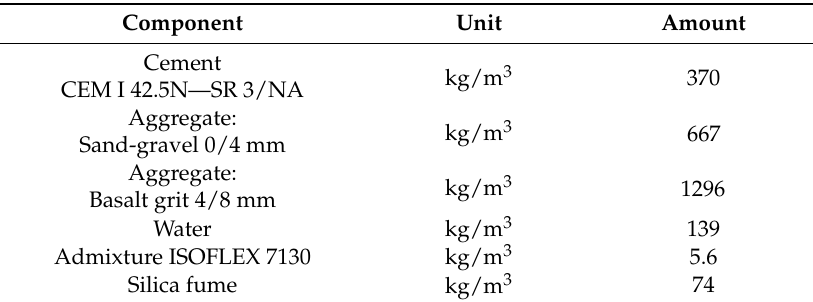
Table 3. A reference recipe for C35/45 concrete.